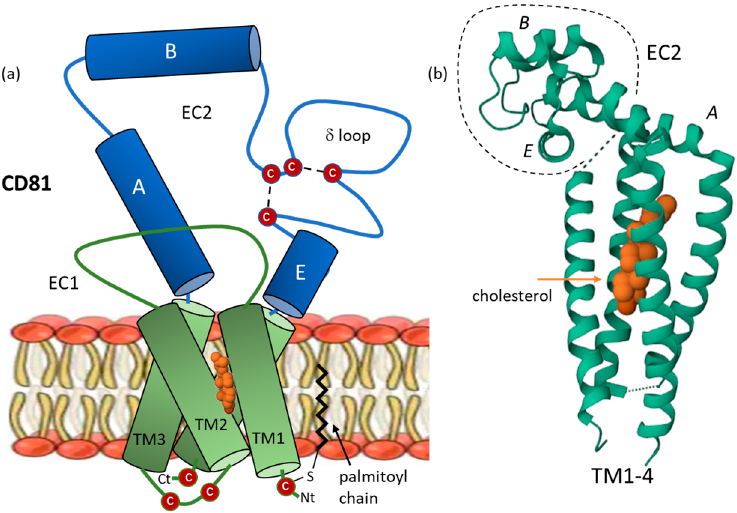
Figure 1. CD81 domain organization and structure. ( a ) Schematic representation of CD81 architecture, with four transmembrane (TM) segments embedded in the membrane bilayer and sequestering a molecule of cholesterol, and two extracellular (EC) loops. The small loop EC1 (or SEL) and the large loop EC2 (or SEL). The disulfur bridges between cysteine residue in EC2 are represented, as well as a palmitoylated cysteine residue contributing the anchoring of the protein into the membrane bilayer. ( b ) A model of CD81, with EC2 in a closed conformation (based in PDB: 5TCX).